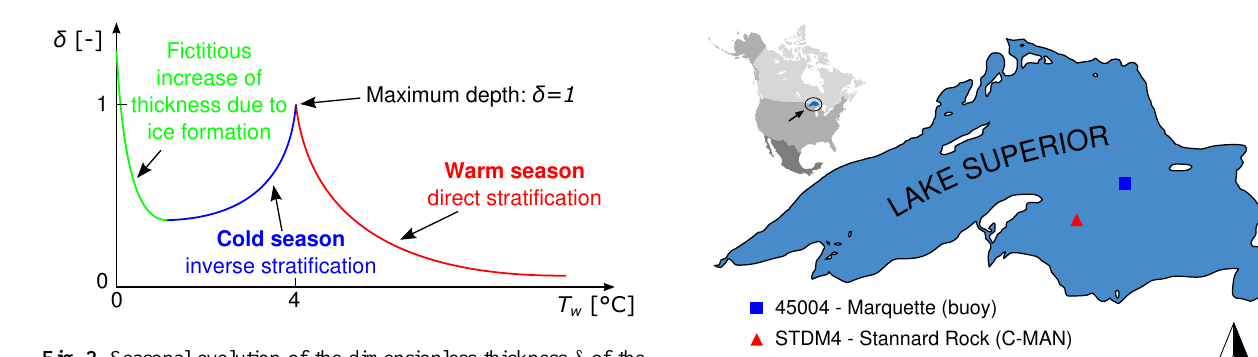
Fig. 2. Seasonal evolution of the dimensionless thickness δ of the surface well-mixed layer for the general case of a dimictic lake.